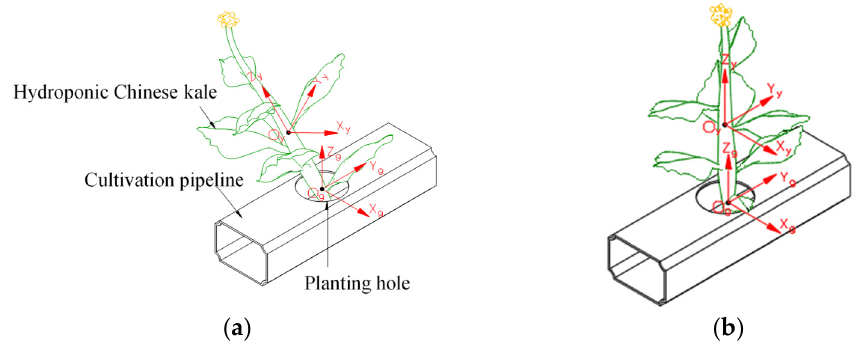
Figure 3. Hydroponic Chinese kale in the planting hole: ( a ) the natural growing kale posture in the planting hole; ( b ) the ideal kale posture for removal from the planting hole. planting hole; ( b ) the ideal kale posture for removal from the planting